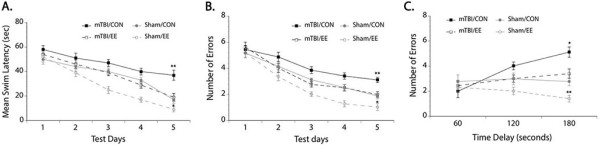
Behavioral performance. Overall, mTBI rats assigned to control housing showed longer mean swim latency (A) and made more errors (B) in the non-matching-to-sample. Increasing time delay between the sample and test trials also resulted in more errors made (C). Remarkably, providing enrichment after injury enhanced functional recovery as seen in the similar performance of the mTBI rats housed in EE and the sham control animals. EE housing in sham animals also led in enhanced behavioral performance. *p < 0.05, **p < 0.01.